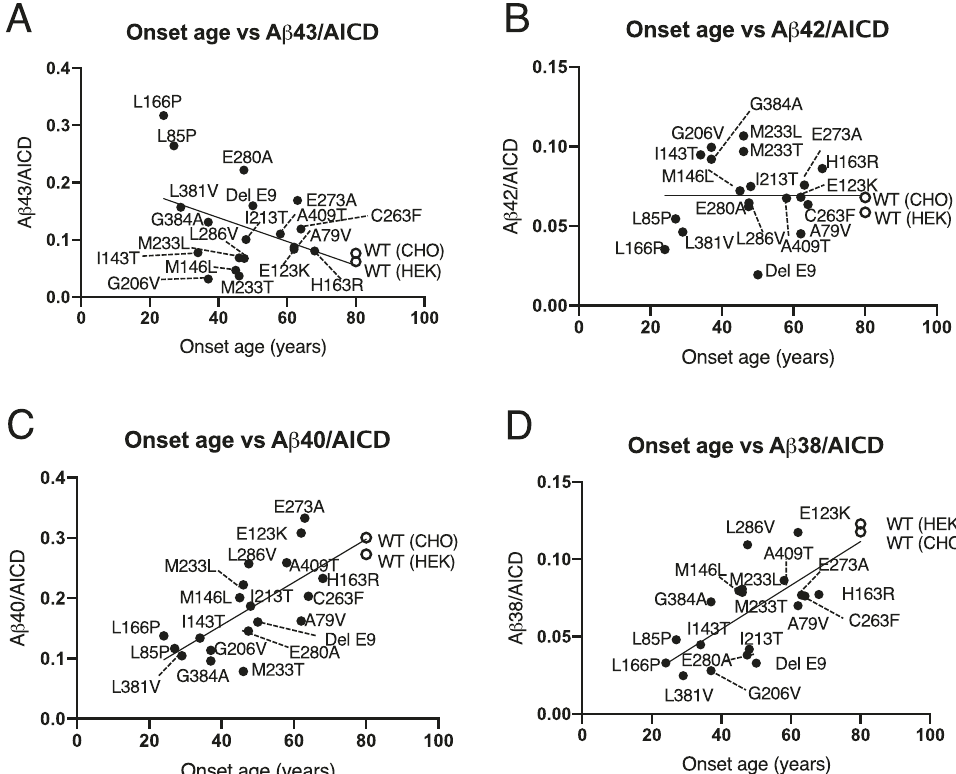
Fig. 4 Onset age versus the ratios of A β /AICD for each FAD mutation. A The ratio of A β 43/AICD increased with age-dependent onset. B The ratio of A β 42/AICD was almost unchanged at all onset ages. C The ratio of A β 40/AICD and D A β 38/AICD decreased with onset age dependency. The open circles indicate WT PS1, and the closed circles indicate FAD mutant PS1. ( n =